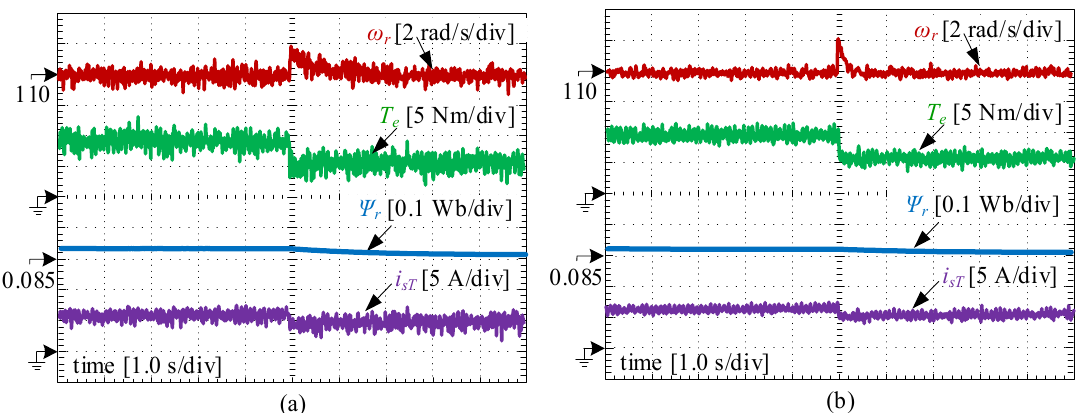
Figure 13. HIL testing results when external disturbances occur. ( a ) Performance of traditional FCS-MPTC with fixed PI parameters and fixed weighting factor. ( b ) Performance of proposed FCS-MPTC with adaptive PI parameters and adaptive weighting factor.